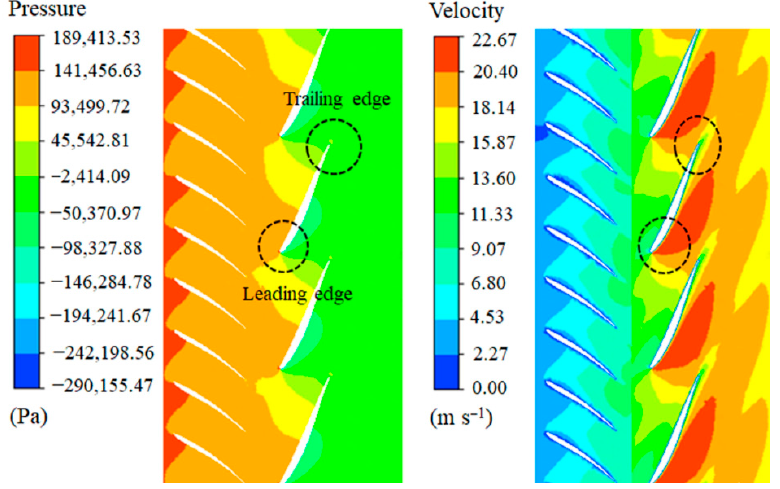
Figure 15. Blade-to-blade pressure and velocity contours (span = 0.5). Figure 16 shows the velocity vector and streamlines of the blade-to-blade guide and runner vane. The figure shows that the guide vane makes the flow pattern non-uniform through the runner vane, and this phenomenon could not reach the desired value. A vortex was also formed near the front of the guide vane and a recirculating flow occurred. Large recirculation flow occurred near the hub of the runner outlet [49].